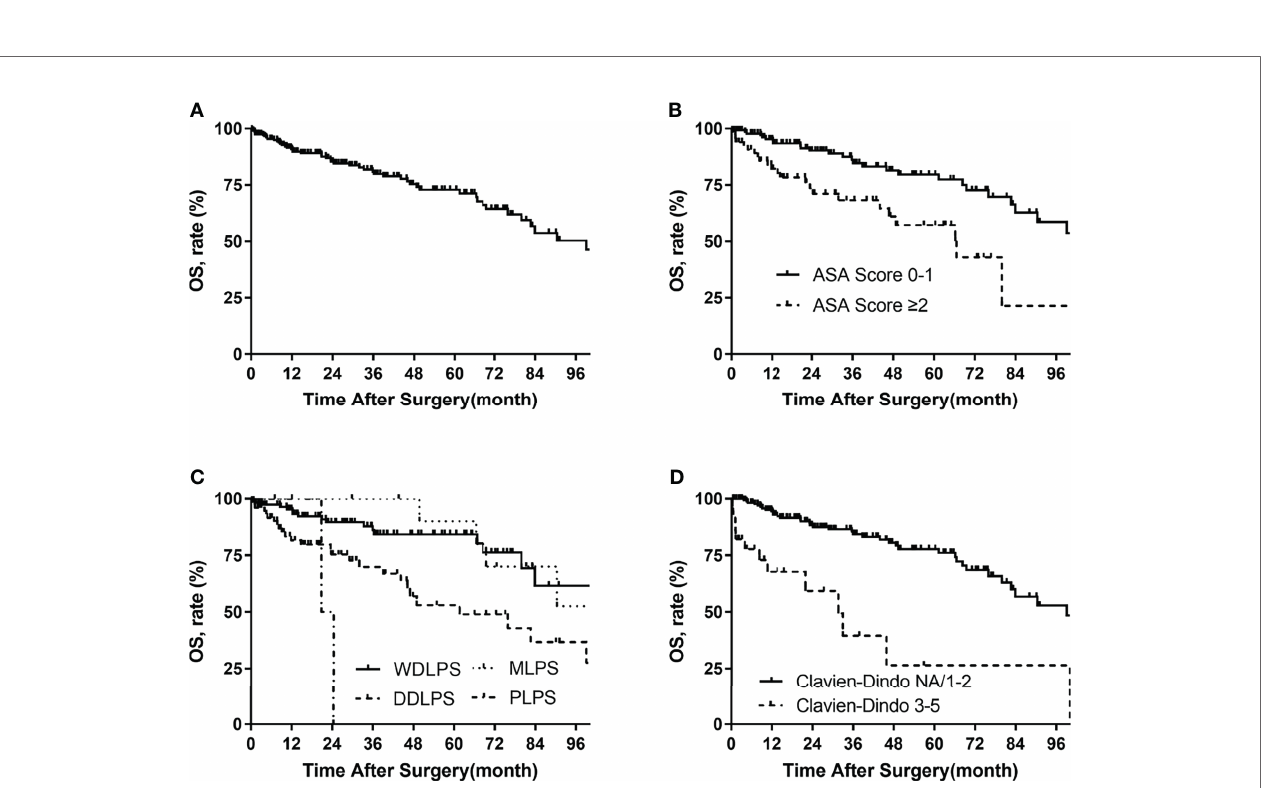
FIGURE 2 | Overall survival in patients with primary retroperitoneal liposarcoma by (A) all patients, (B) ASA score, (C) histologic subtypes, and (D) Clavien – Dindo classi fi